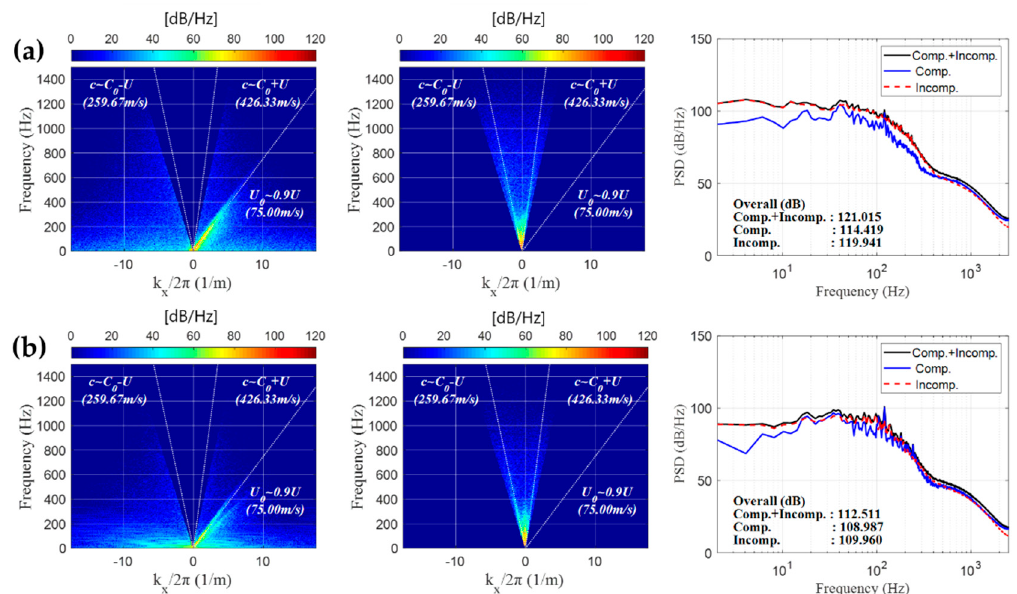
Figure 18. Decomposed power spectral density diagram of incompressible (left), compressible (middle) parts at a given k y , k z = 0 and power spectral density levels by integrating over all wavenumbers (right)—reference pressure 20 µ Pa: ( a ) roof wall region; ( b ) left-side wall region.